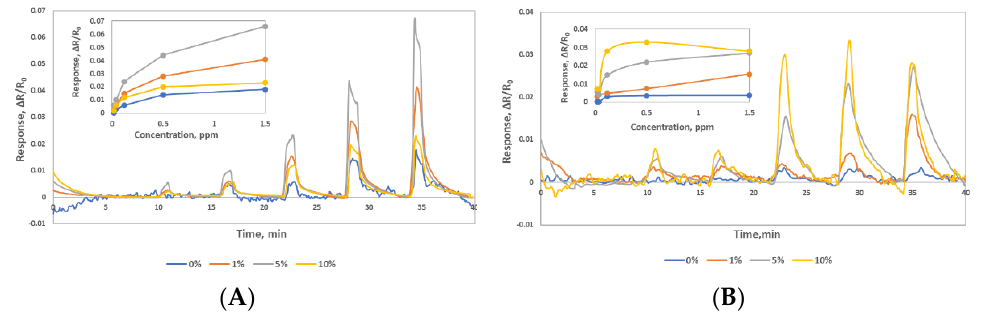
Figure 1. Response of a sensor chip to 0.02, 0.04, 0.12, 0.5 and 1.5 ppm NO gas. Each line represents the composite material made with varying loading of Au NPs onto SWCNTs-COOH. ( A ) sensor response in dry condition ( B ) sensorresponse in 92%